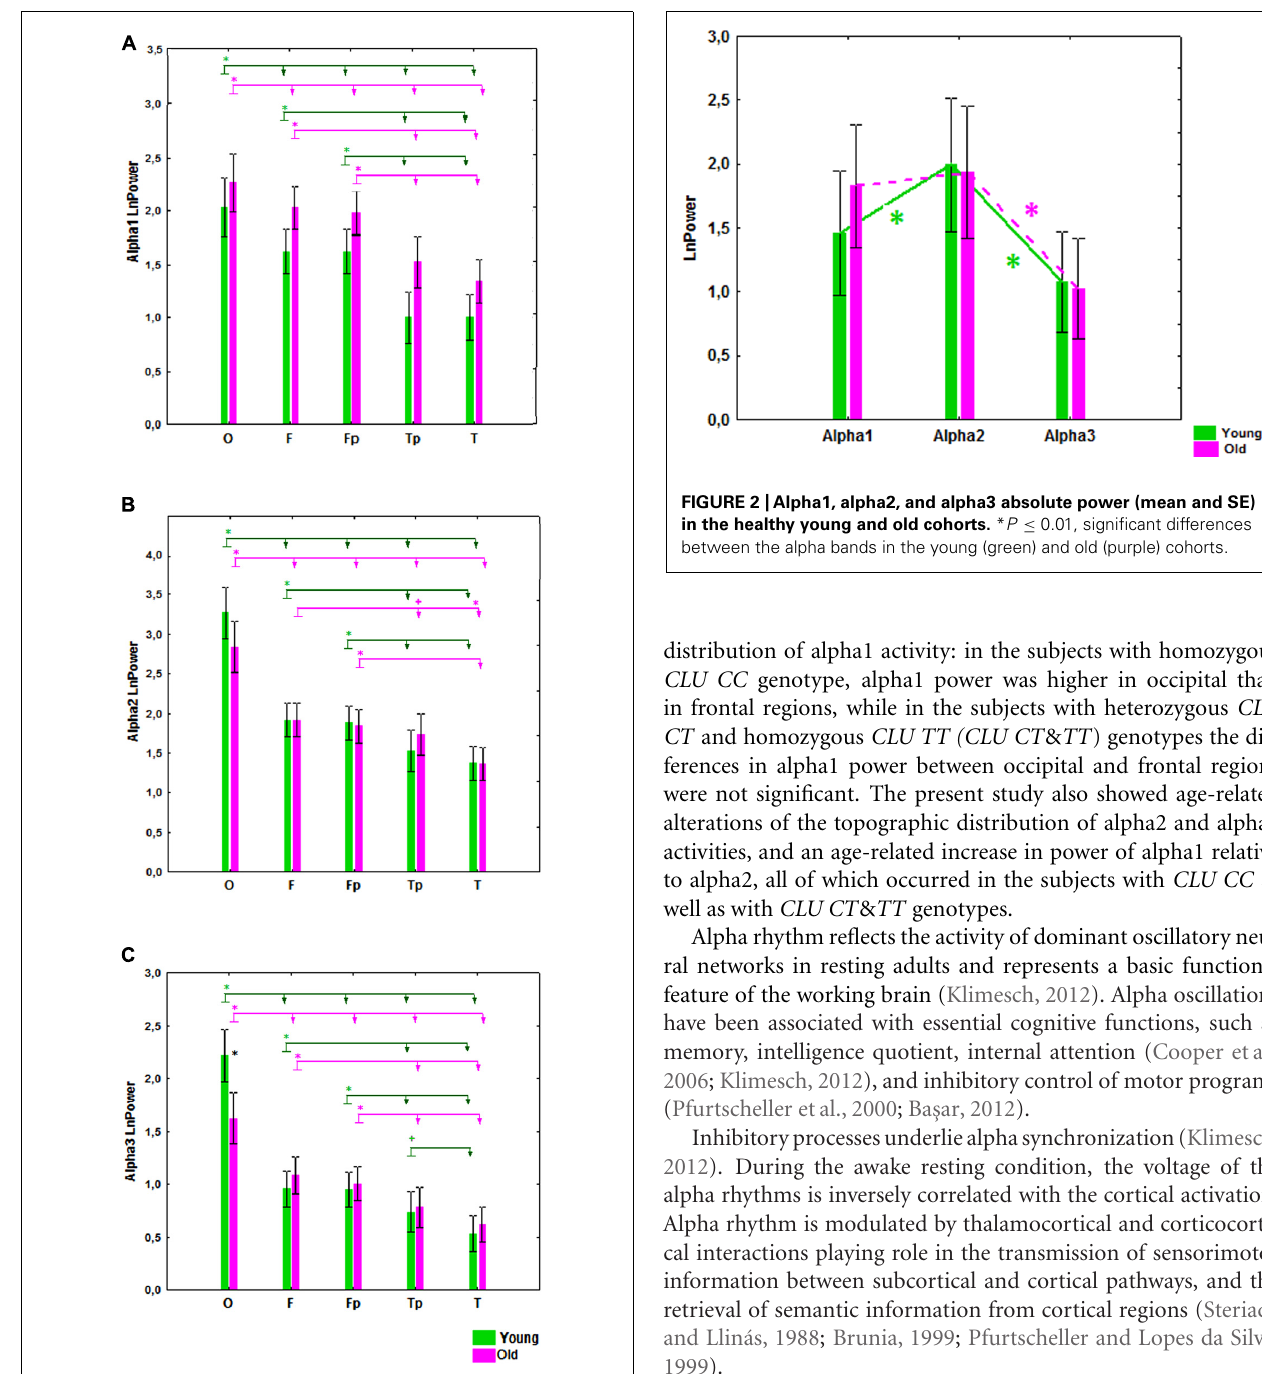
FIGURE 1 |Absolute power (mean and SE) of alpha1 (A), alpha2 (B), and alpha3 (C) bands in the young and old cohorts, for occipital (O), frontal (F), frontal poles (Fp), temporal posterior (Tp), and temporal (T) areas. Black asterisks (*) indicate a P < 0.01 significant difference in absolute spectral power between two cohorts in the same region of interest (ROI).The arrows labeled with green (for the young cohort) and purple (for the old cohort) asterisks compare different ROI in the same cohort.The ROI at the start of the arrow has either ( + ) P < 0.05 or (*) P < 0.01 significant differences in absolute spectral power compared the ROIs at the ends of the arrow.